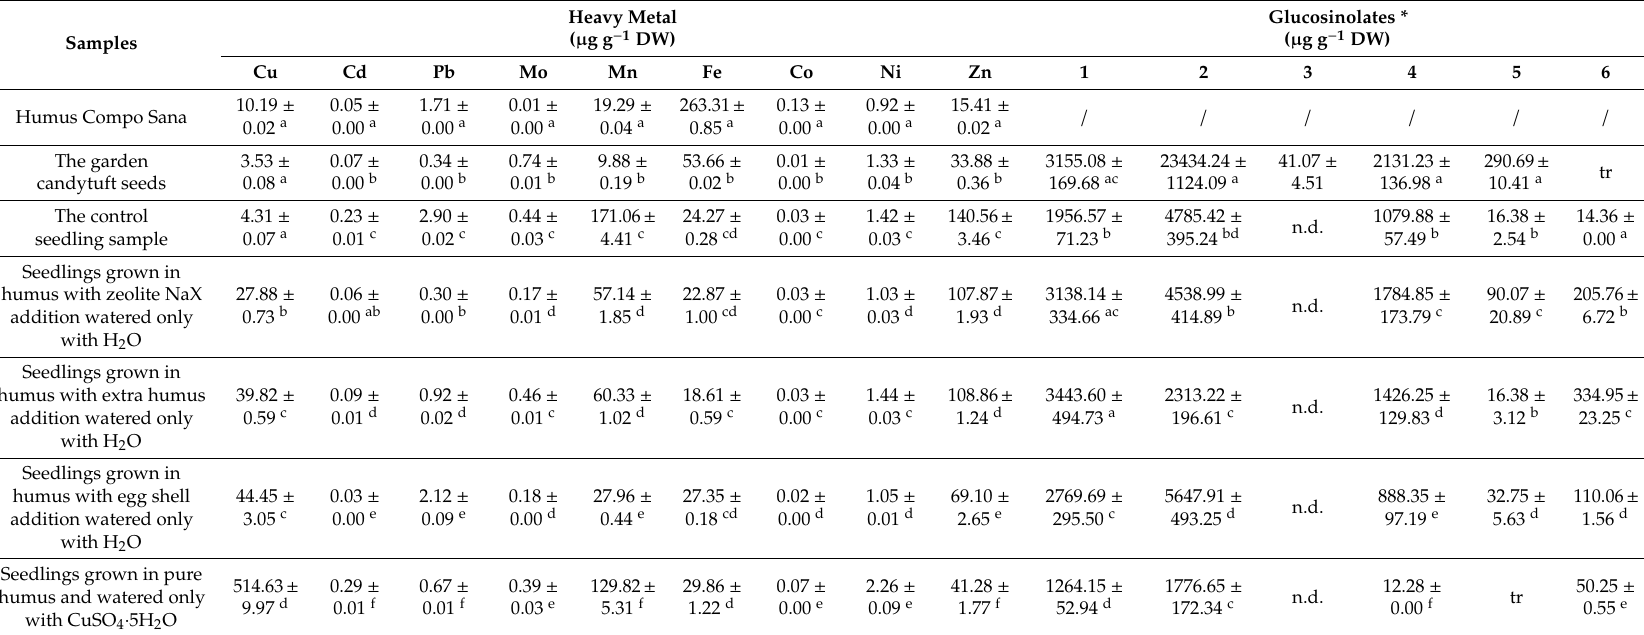
Table 2. Measured heavy metals concentration in the garden candytuft seeds, and the cultivated garden candytuft (total seedlings biomass), respectively.